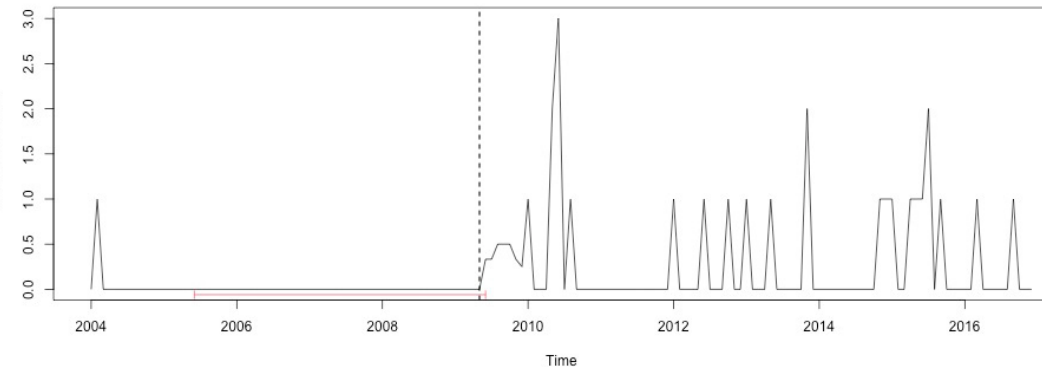
Figure A34. Precursor Vietnamese arrests 2004–2016 in the Czech Republic and structural breaks.